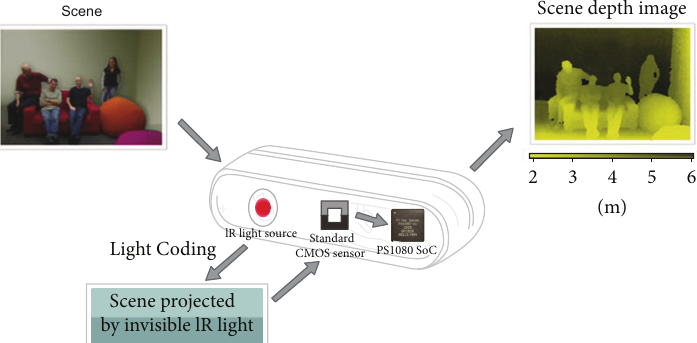
Figure 1: The procedure of object detection of Light Coding method (PrimeSense).